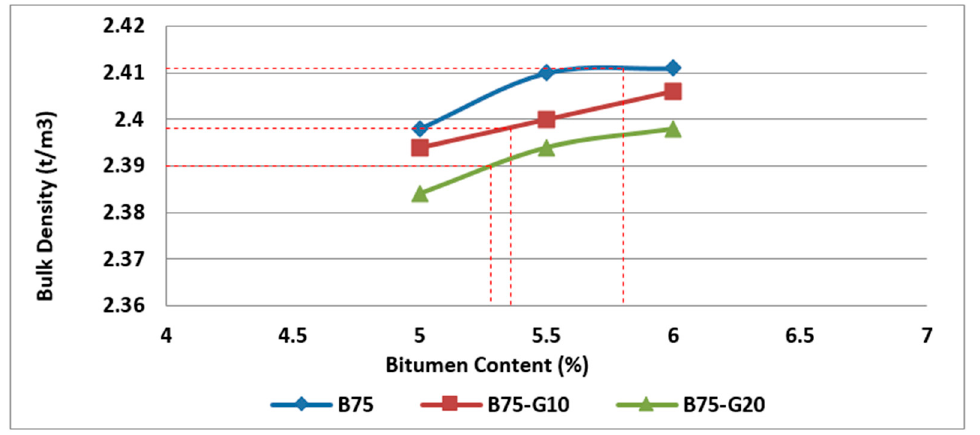
Figure 15. Effect of bitumen content and glass content on bulk density of Mix II containing 25% RCA without glass and Mix IV and Mix V containing 25% RCA as coarse aggregate and glass as fine aggregate.